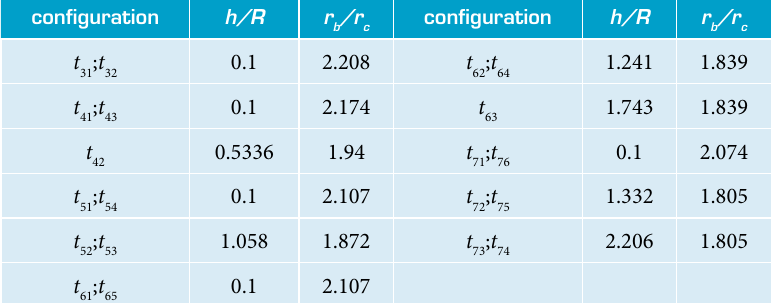
Table 1. Optimum structural parameters combination of each